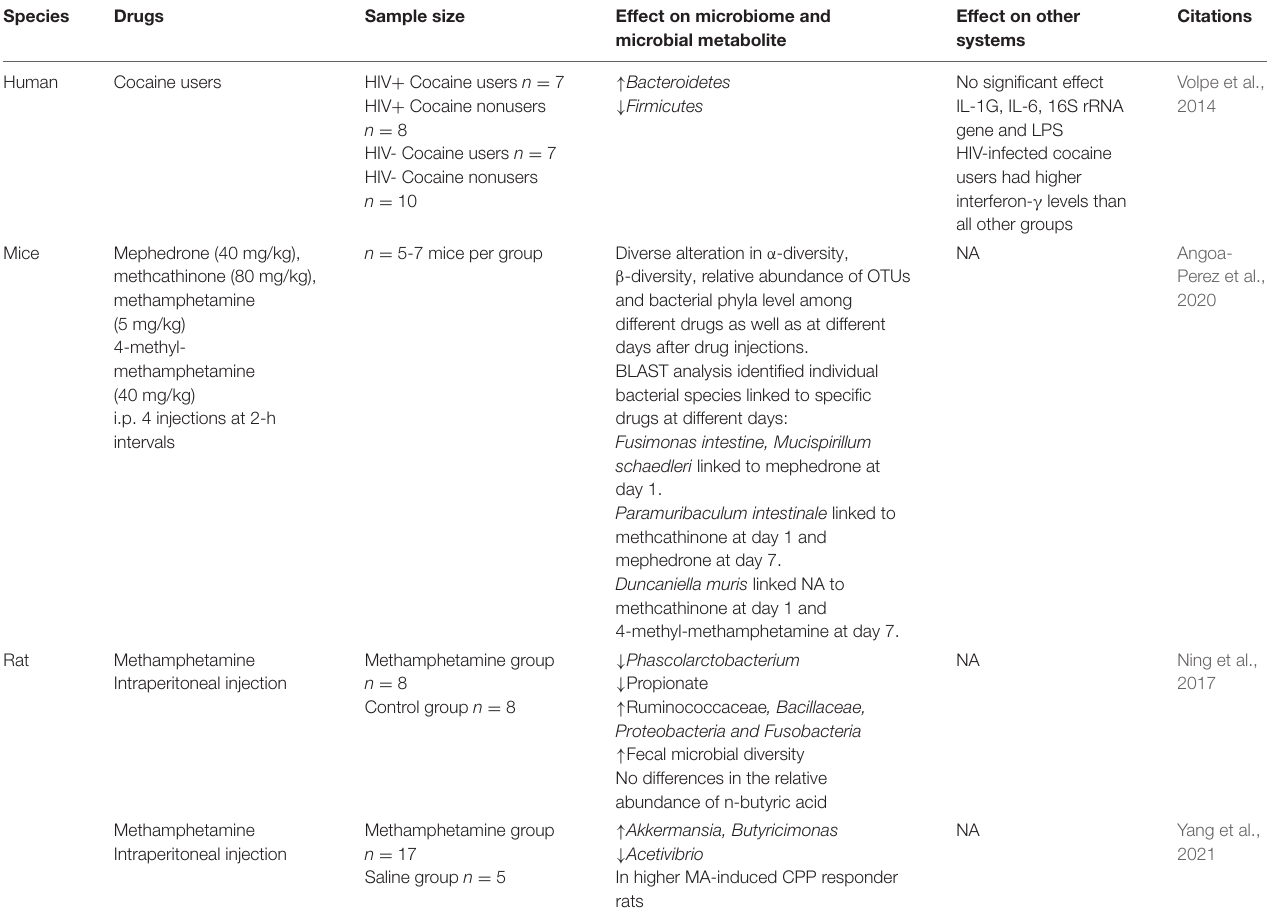
TABLE 6 | Effects of psychostimulants on gut microbiome and other systems.